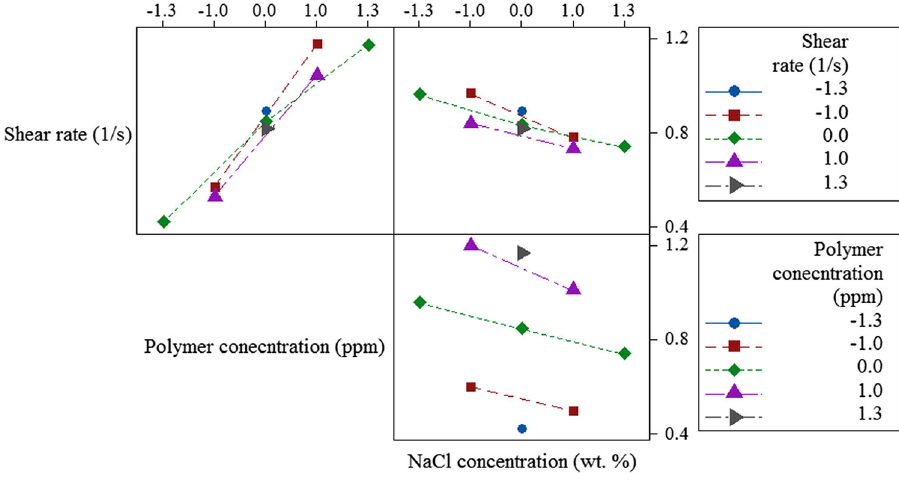
Fig. 7 Interaction plot for viscosity (data